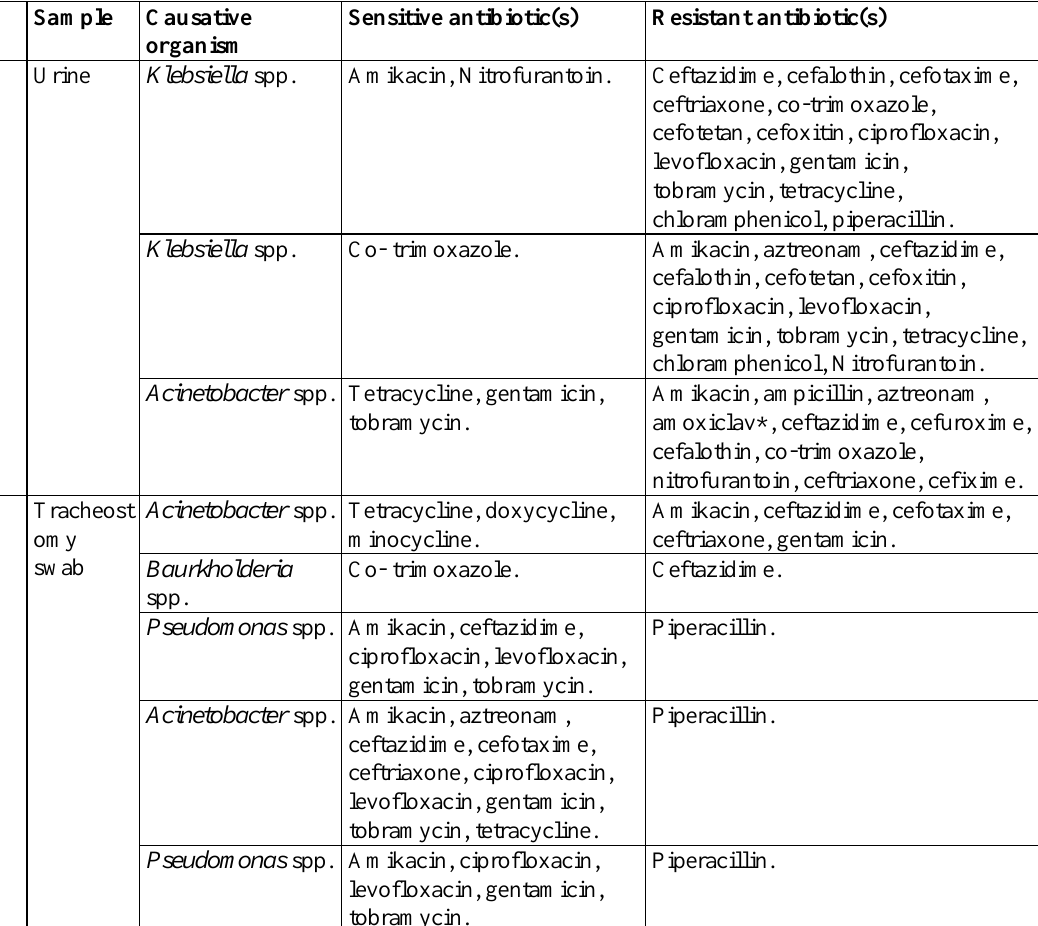
Table (4): Causative bacteria isolated from patients and their sensitivity to antibiotics in each sample in the